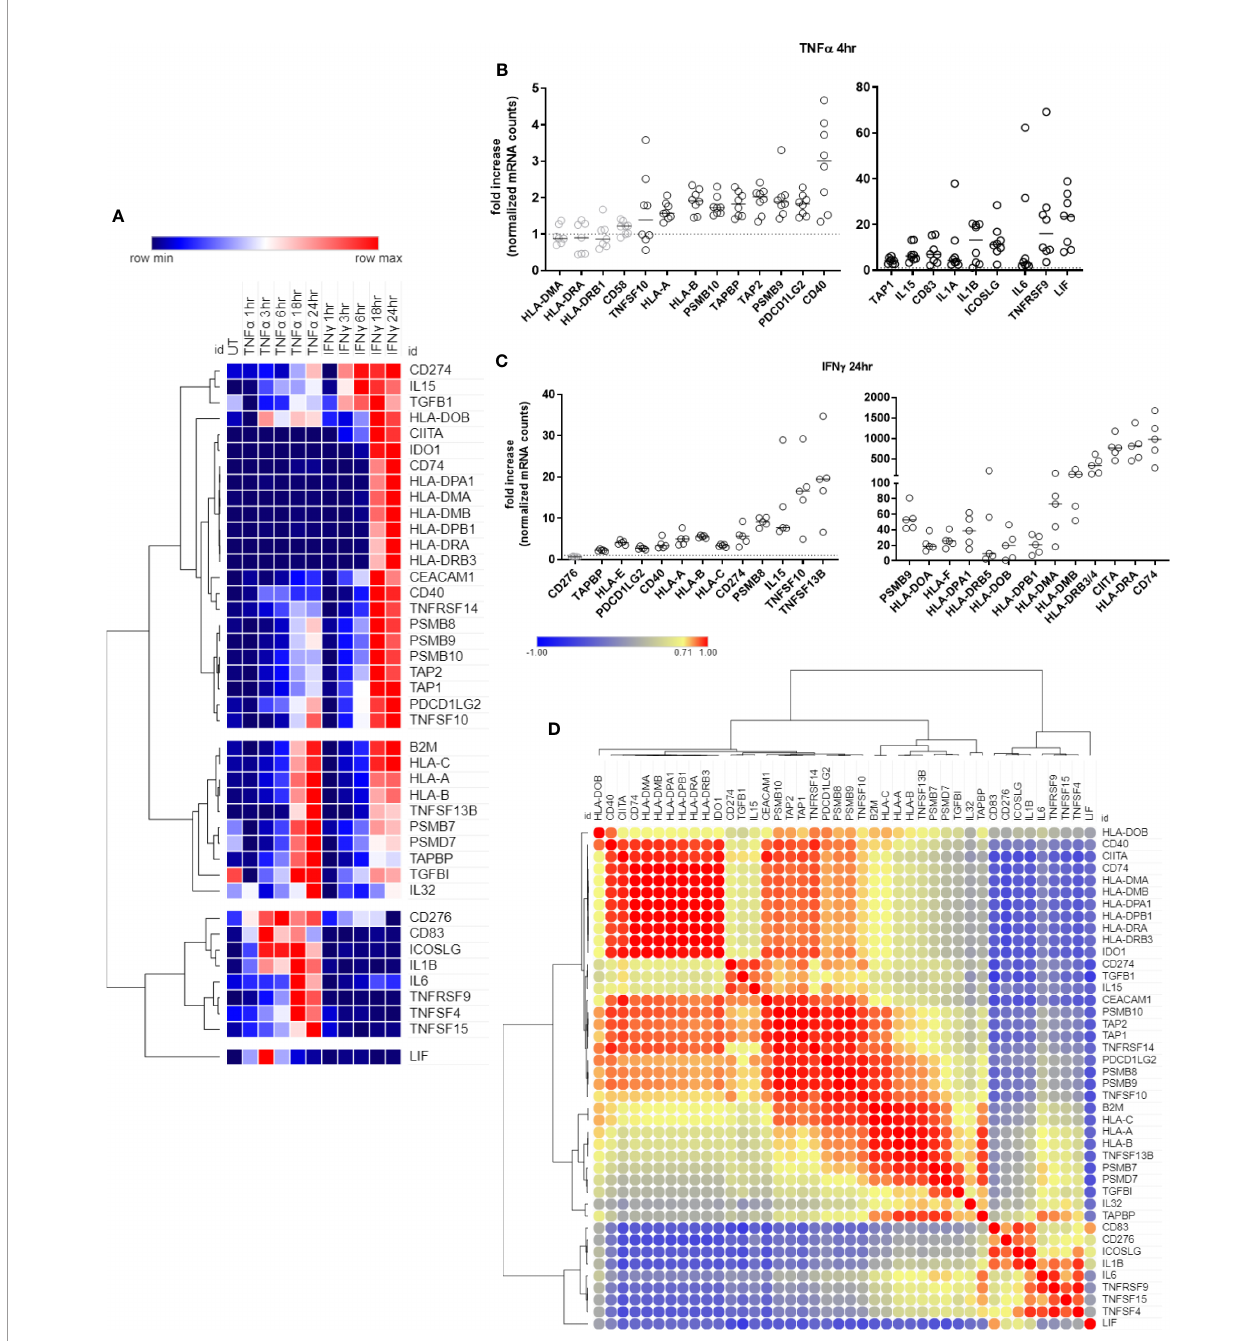
FIGURE 1 | Time course of antigen presentation, costimulatory molecule and cytokine genes after TNF a or IFN g stimulation. (A) . HMEC-1 endothelial cells were stimulated with TNF a (20ng/mL) or IFN g (200U/mL) for 1hr, 3hr, 6hr, 18hr or 24hr. mRNA counts were measured by Nanostring and normalized to housekeeping genes and controls. Heat map shows relative gene expression over time, with normalization across genes/rows. Hierarchical clustering of rows is by one minus Pearson correlation. (B) . Primary human endothelial cells (HAEC, HCAEC, HCMVEC, HPAEC, HPMVEC, HDMVEC, HRGEC, HLSEC) were stimulated with TNF a (20ng/mL) for 4hr, and transcript levels were measured by Nanostring. The fold change in normalized mRNA counts was calculated compared to untreated conditions for each EC type (n=8). (C). Primary human endothelial cells (HPAEC, HRGEC, HPMVEC, HLSEC) were stimulated with IFN g (200U/mL) for 24hr, and transcript levels were measured by Nanostring. The fold change in normalized mRNA counts was calculated compared to untreated conditions for each EC type. (n=4). (D). Similarity of costimulatory, cytokine and antigen presentation gene expression across untreated, TNF a and IFN g treated endothelial cells. Heat map similarity matrix shows temporal and context dependent correlation. Hierarchical cluster analysis and the similarity matrix were generated by MORPHEUS using Pearson correlation